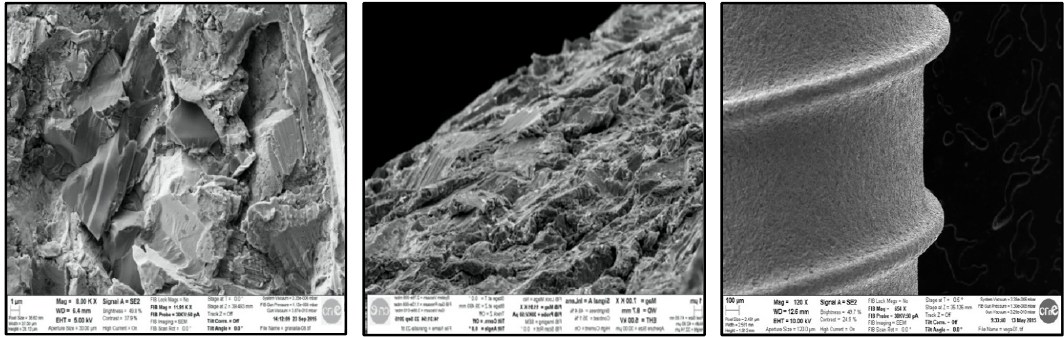
Figure 1. Implant surface, SEM photos of the shotblasted surface. It can be seen at different magnifications: first and second (1 µm) third (100 µm).